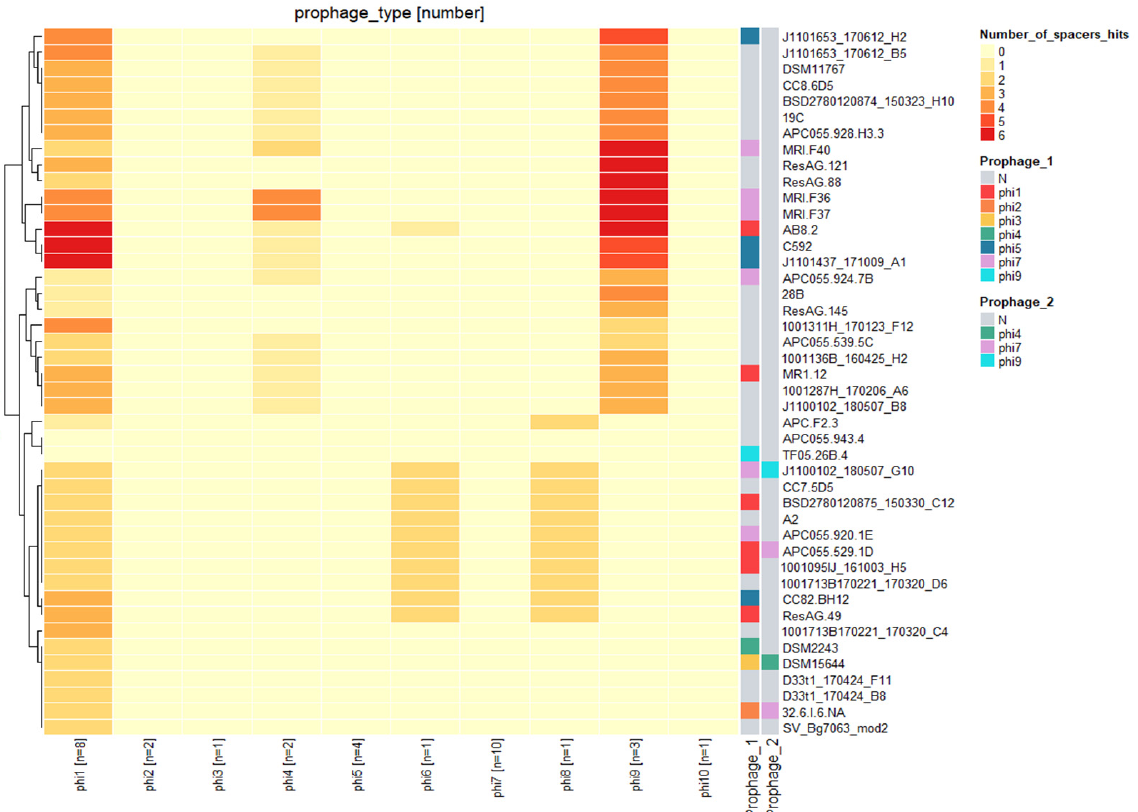
Figure 8. Heatmap illustrating spacer sequence hits among the CRISPR array of different E. lenta isolates (y-axis) and E. lenta prophage clades (x-axis) with the number of representatives for each clade identified in brackets. The analysis utilised 283 spacers from CRISPR arrays of 44 E. lenta strains identified to target prophages of the species.